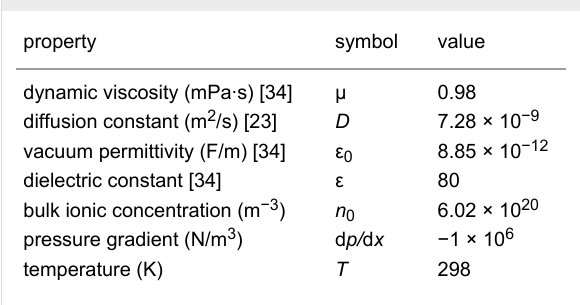
Table 1: The properties of DI water and